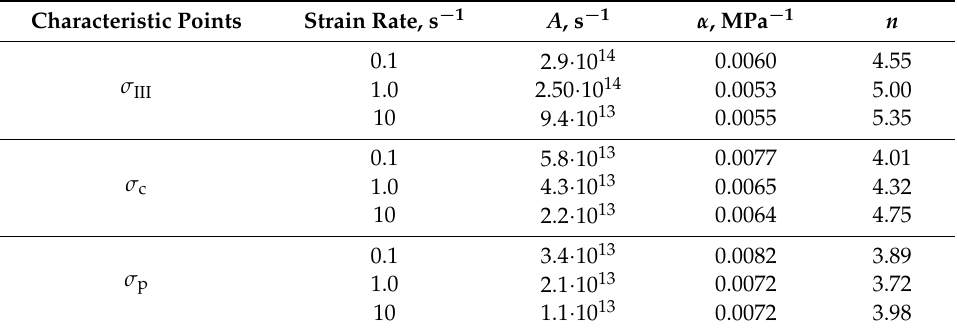
Table 2. Parameters of constitutive equation for strain-hardening rate characteristic points. Characteristic